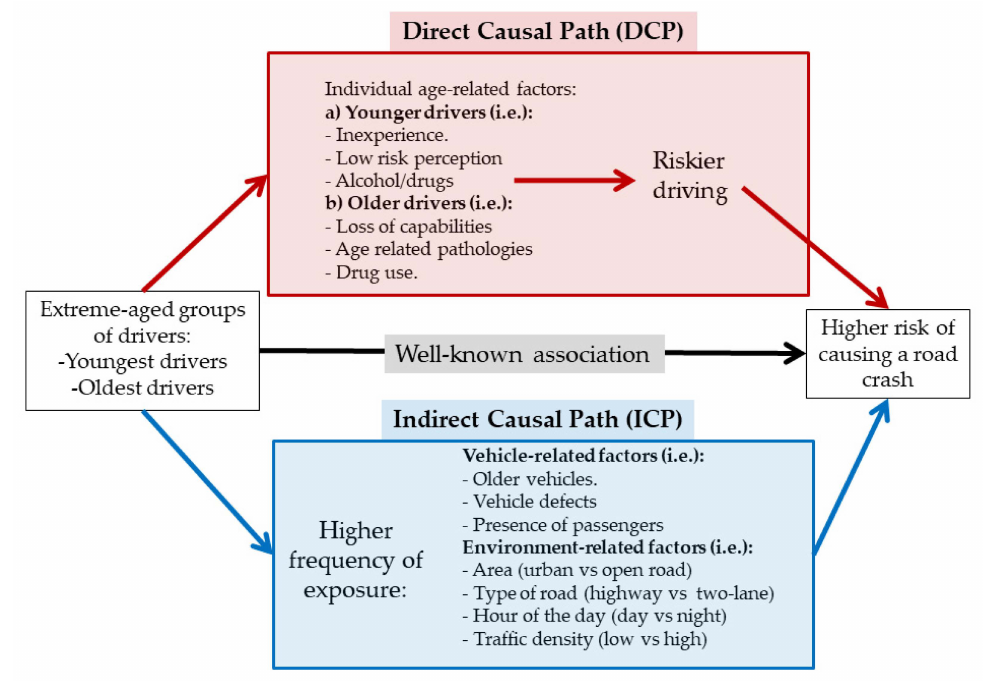
Figure 1. The two possible casual paths that could explain the association between drivers’ age and the risk of causing a road crash. Directed acyclic graph